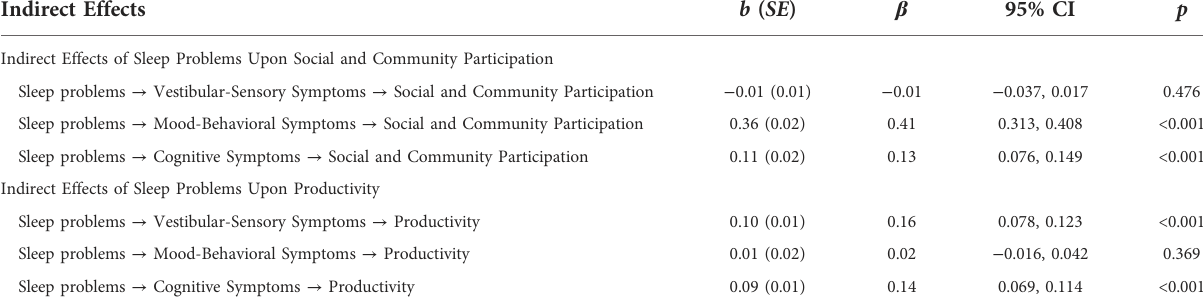
TABLE 4 Parameter estimates for indirect effects ( n =8,733). Indirect